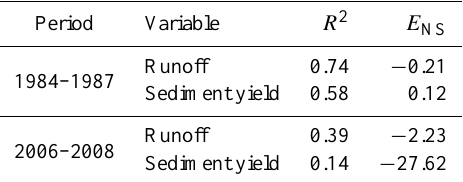
Table 4. The modeling efficiencies of 1984–1987 and